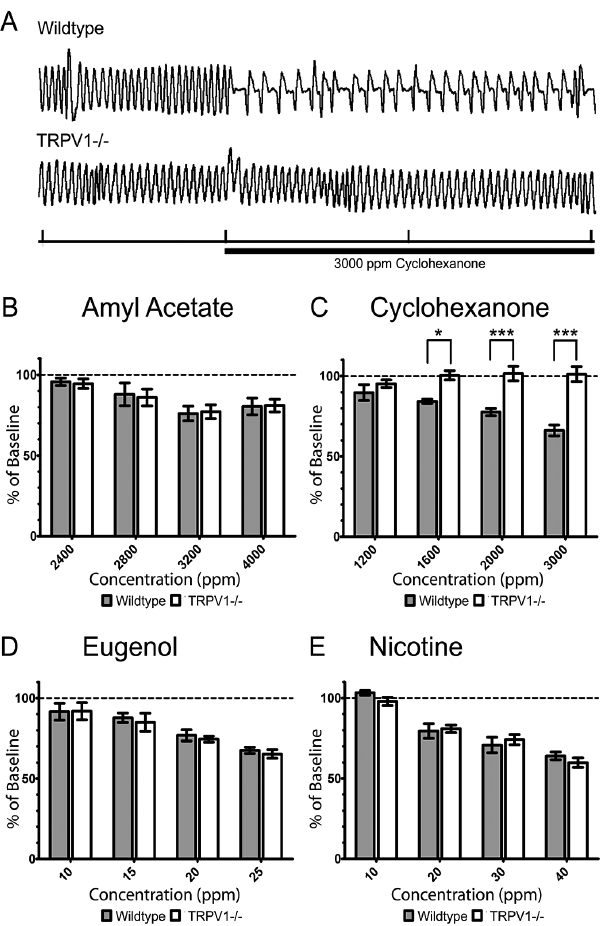
Figure 4. Respiration rate depression in response to trigeminal irritants. ( A ) Sample traces from a wildtype and TRPV1 knockout mouse in a double-chambered plethysmograph showing the typical respiratory response to 3000 ppm cyclohexanone (marked by horizontal bar). Tick marks on the x -axis indicate 6 sec. ( B – E ) Percent respiratory depression of four animals expressed